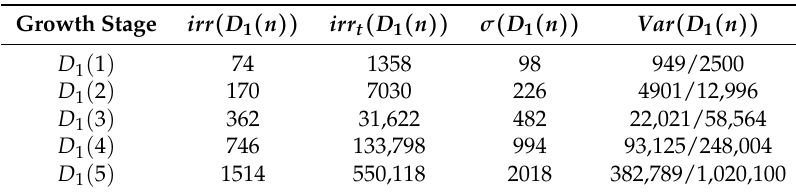
Table 1. The values of irregularity indices of structure of Polyamidoamine (PAMAM) dendrimers against different generation